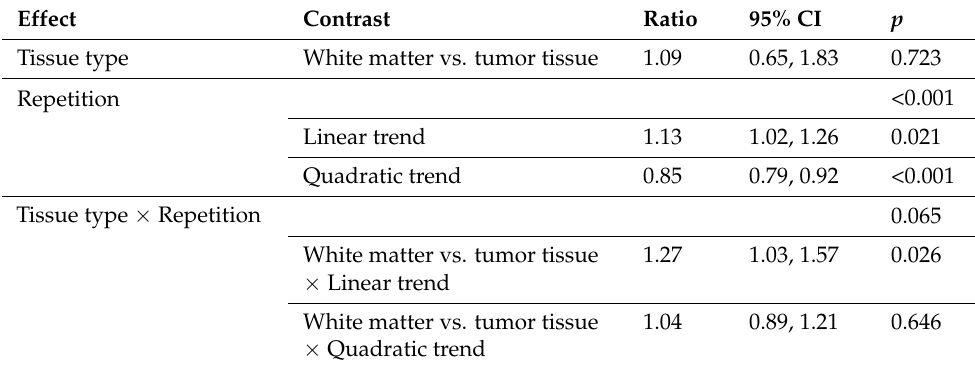
Table 3. Fixed effects in the linear mixed-effects model of the association between the elastic modulus and repetitive indentation (repetitive indentation model).